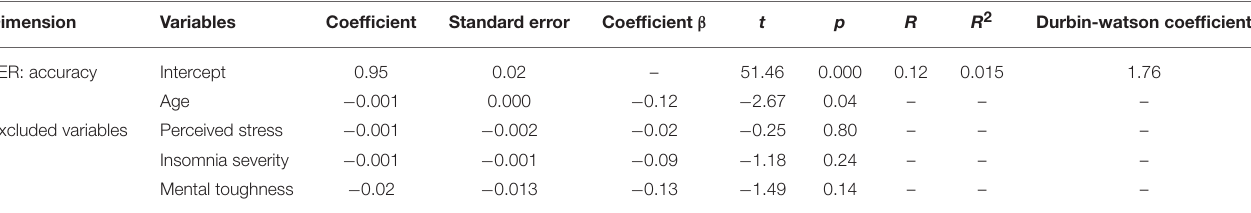
TABLE 3B | Multiple linear regression with facial emotion recognition accuracy as dependent variable, and age, perceived stress (PSS), insomnia severity (ISI), and mental toughness as predictors.